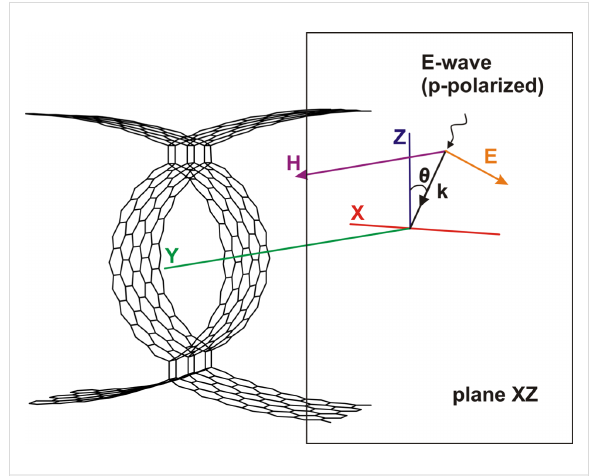
Figure 2: A fragment of the 2D CNT–graphene hybrid nanocomposite and configuration of an incident electromagnetic